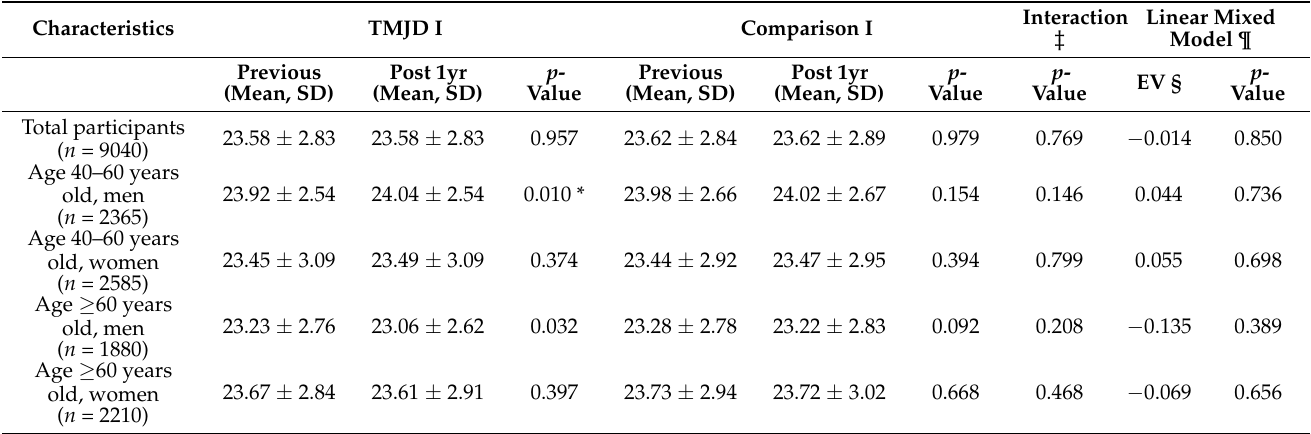
Table 2. Differences in mean BMI between pre- and 1-year-post-study of TMJD in Study I according to age and sex.